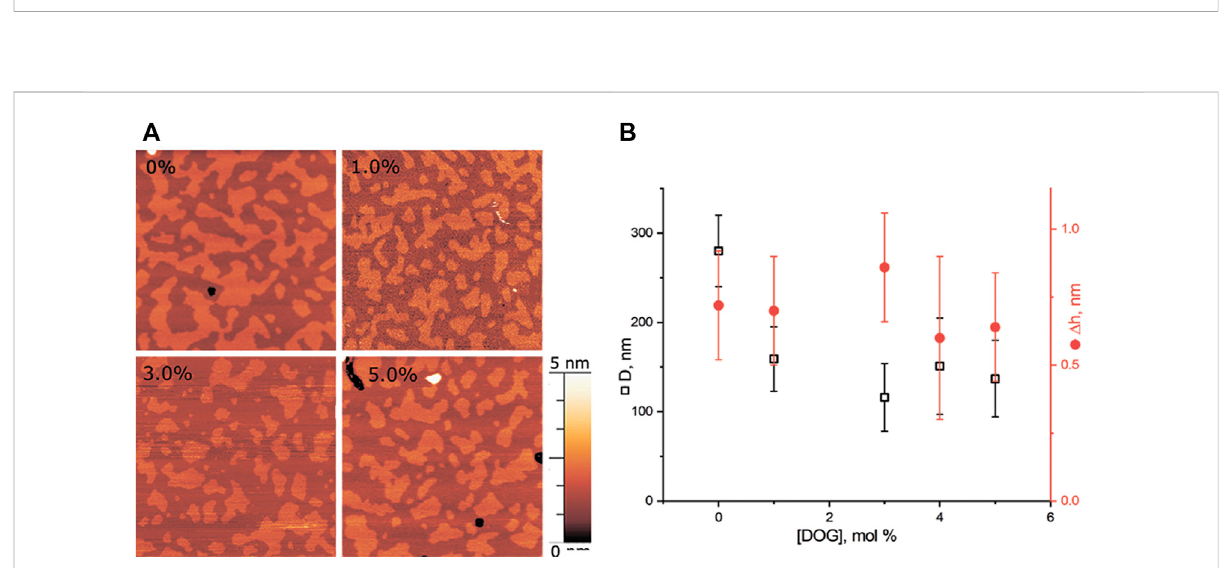
FIGURE 5 DOG in the eSM/DOPC/Chol = 1:1:1 membrane. (A) AFM images of the membrane. Size of each image is 3 μ m × 3 μ m. Amount of DOG in the membrane in mol% is indicated in each image. (B) Dependence of the average diameter of rafts (black) and their height above the surrounding membrane (red) on the molar fraction of DOG in the